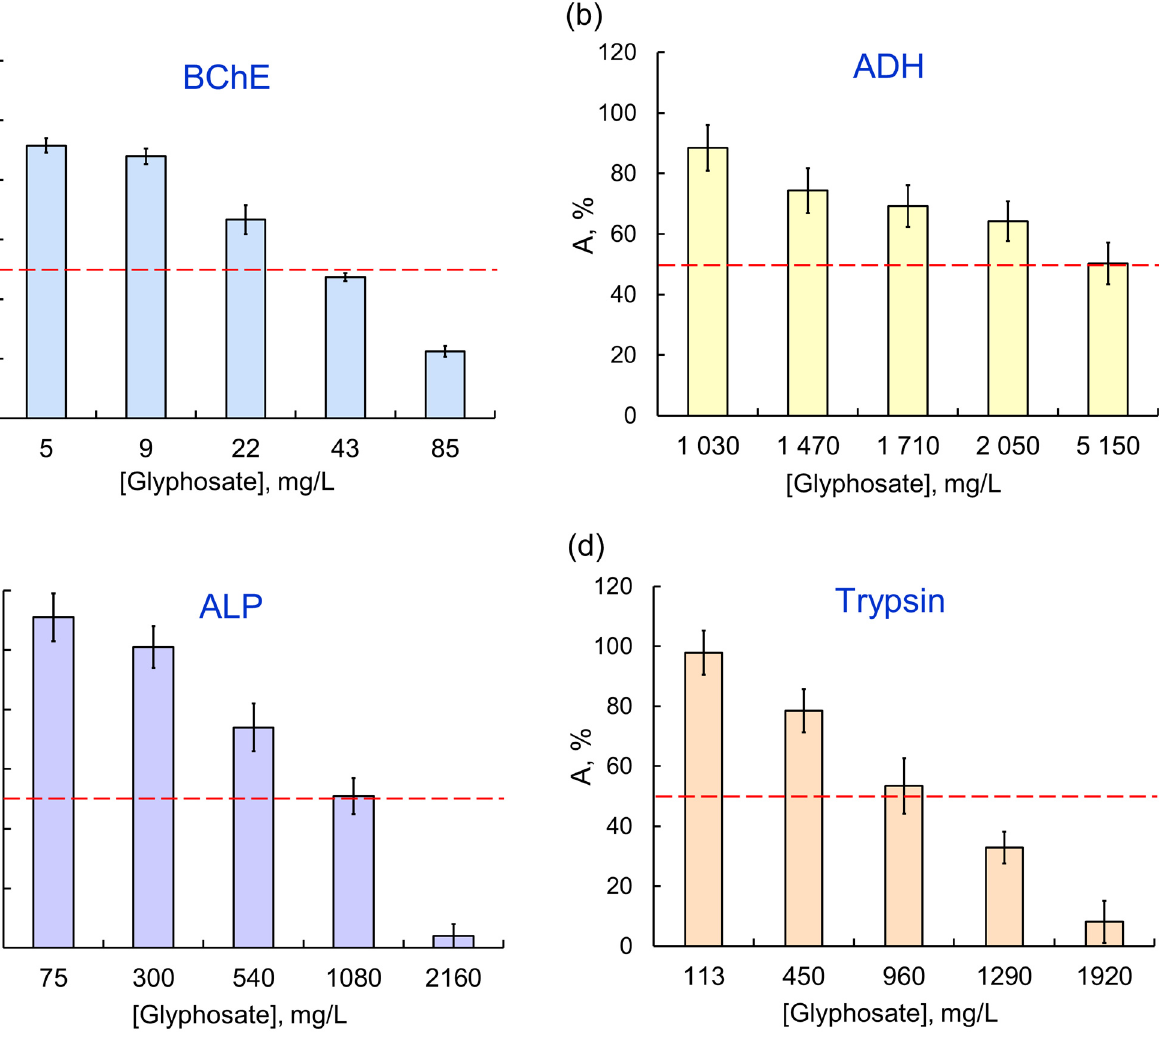
Figure 2. The effect of glyphosate as AIa on single-enzyme assay systems: ( a ) BChE; ( b ) ADH; ( c ) ALP; ( d ) trypsin. The assay systems differ in their sensitivity to the same AIa (glyphosate); the IC 50 values for BCh, ADH, ALP, and trypsin are 0.035, 5.14, 1.08, and 0.96 μ g/L, respectively.